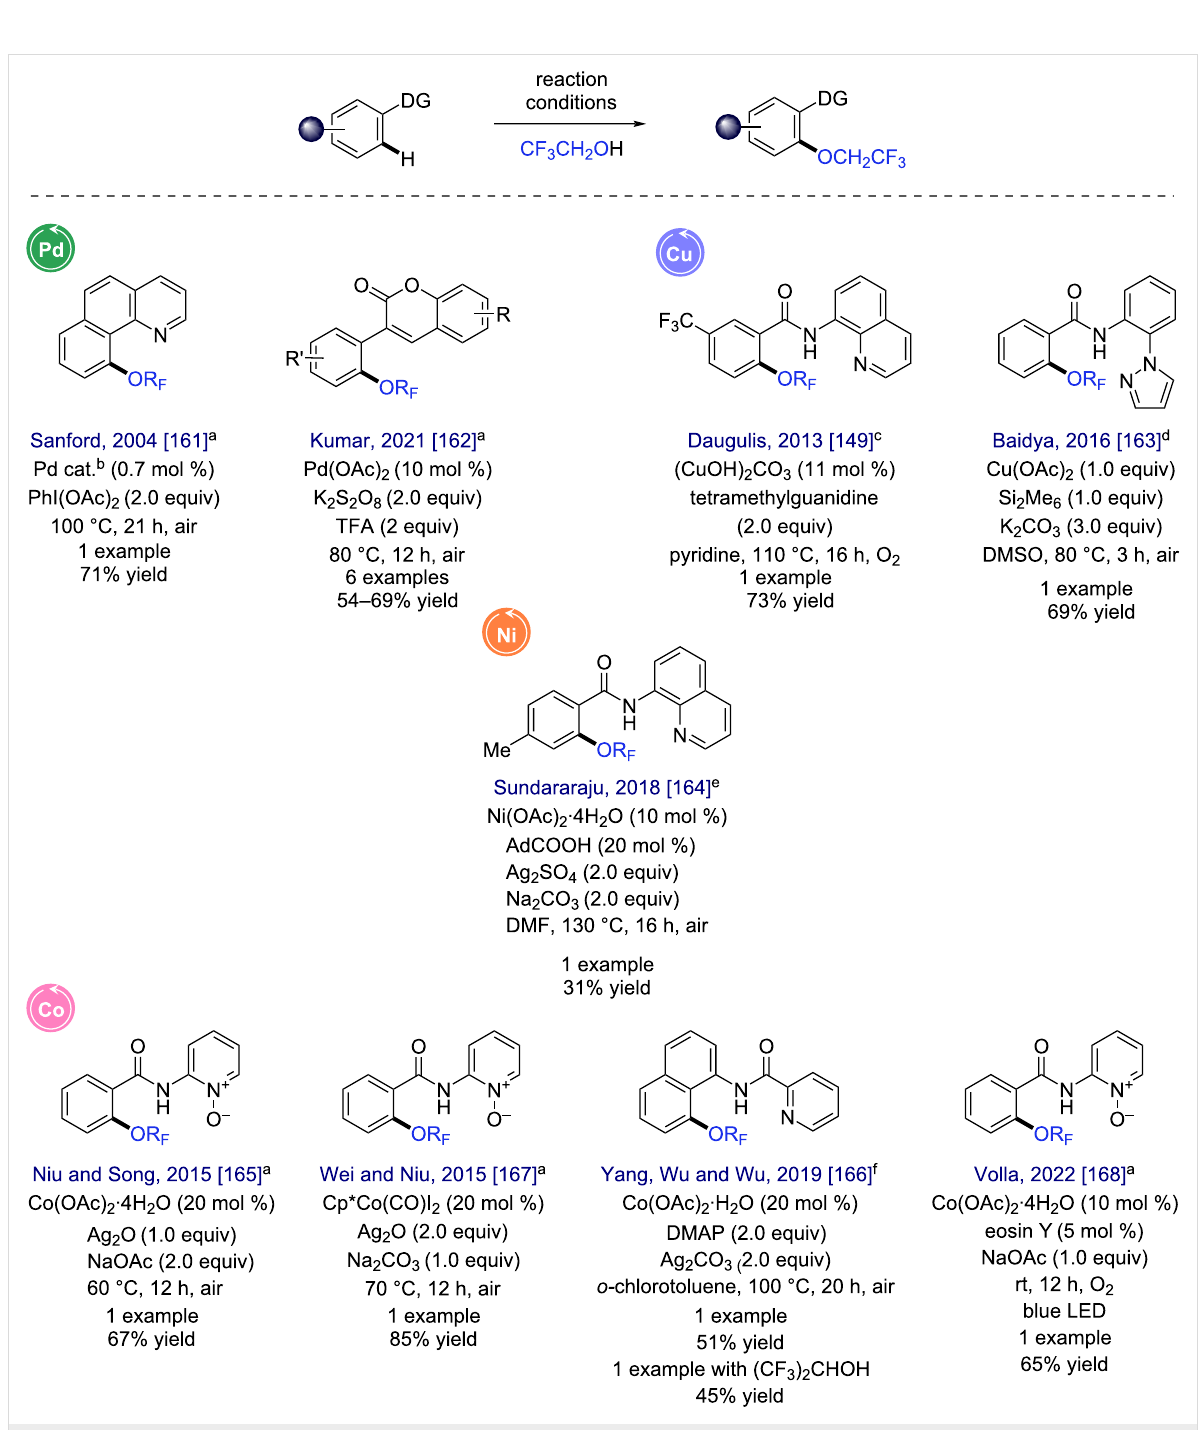
nalization of diversely substituted derivatives bearing either electron-donating groups ( 41b , 41d , and 41f ) and